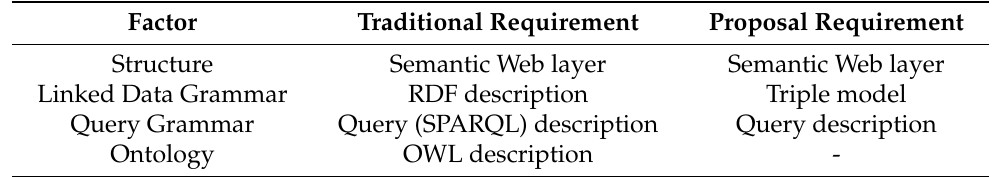
Table 1. Comparison with traditional